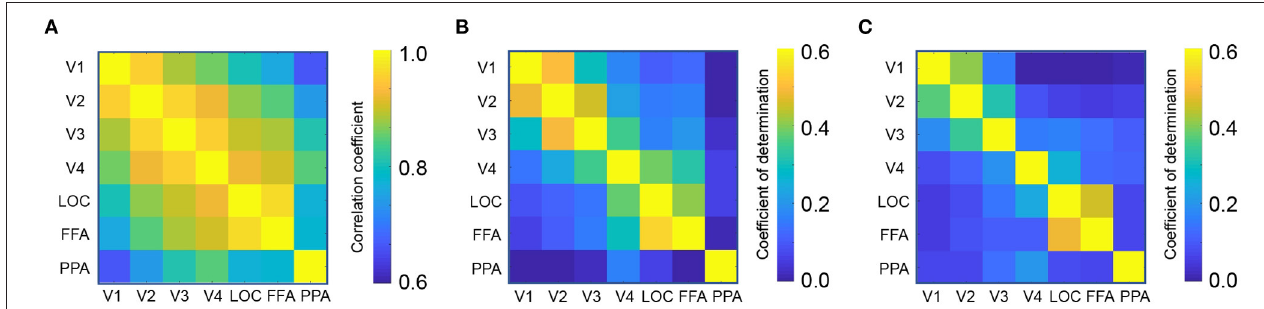
FIGURE 2 | Region-to-region decoding. (A) Connectivity matrix between visual object recognition related regions. (B) Coefficient of determination in the perception test. (C) Coefficient of determination in the imagery test.